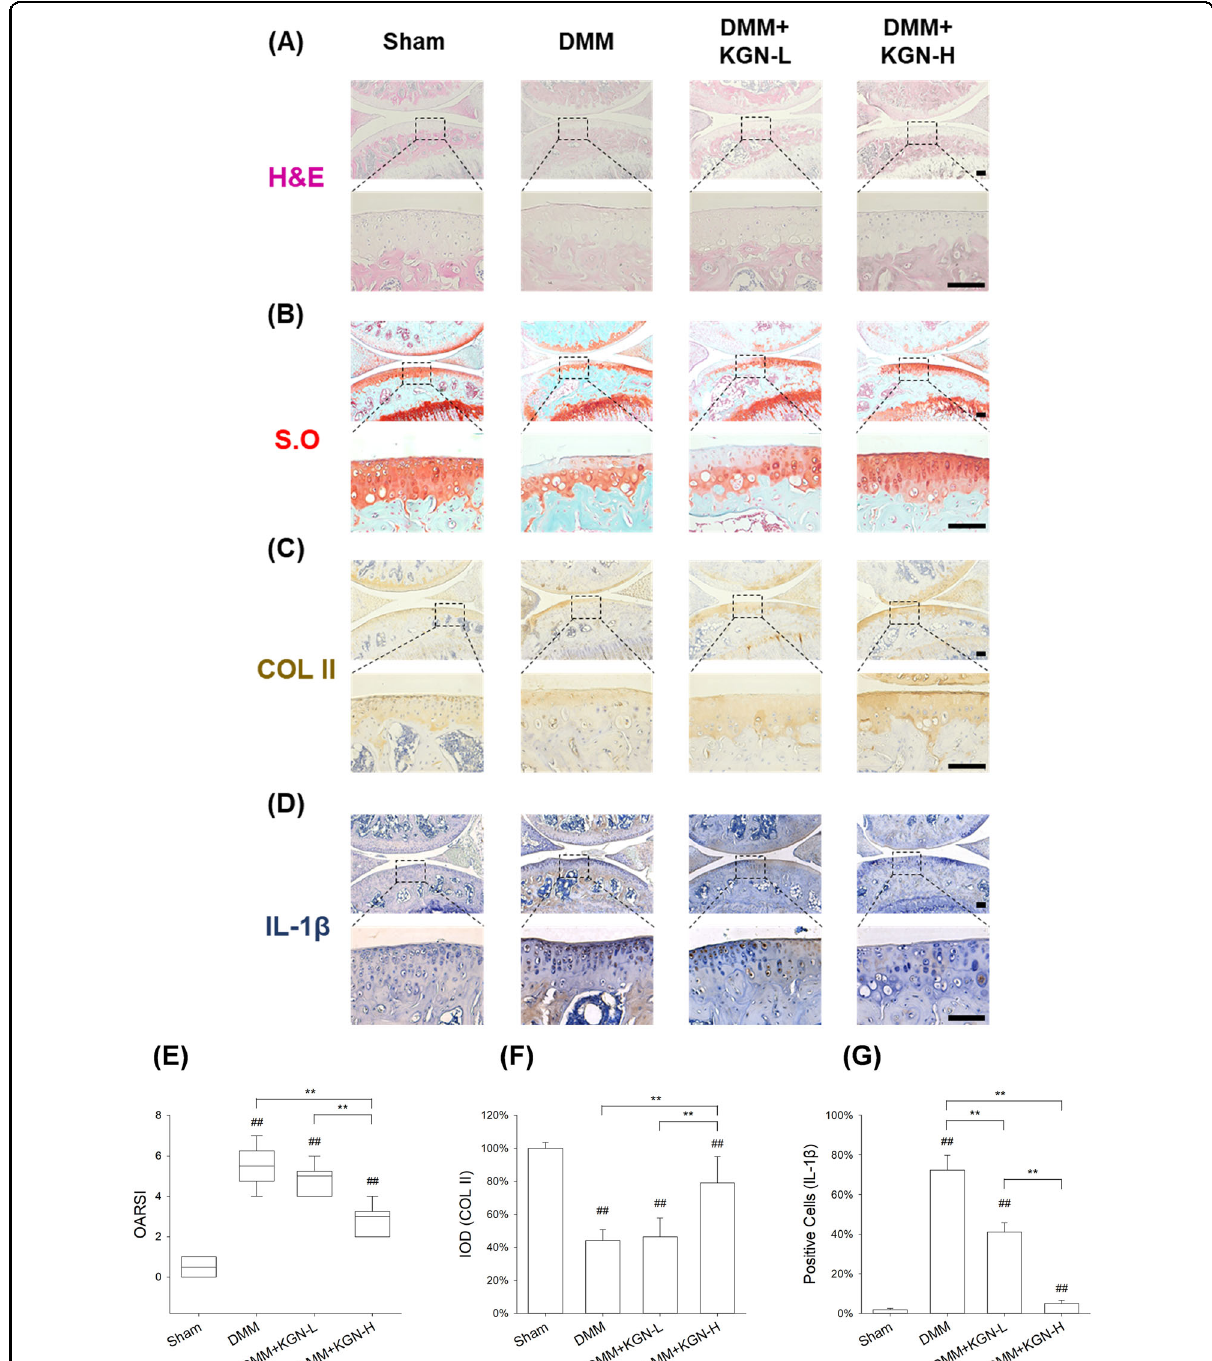
Fig. 3 Effect of intra-articular injection of KGN on the degeneration of cartilage in DMM-induced OA in mice. DMM-op mice were injected with 1 μ M or 100 μ M of KGN, twice a week for four weeks, whereas the controls were injected with 10 μ L of saline. A – D Representative histological images of medial femoral condyle and tibial plateau of OA mice following immunohistochemical staining. Sagittal sections of cartilage following A hematoxylin and eosin (H&E) staining, B Safranin O (S.O.)/Fast Green staining, C immunohistochemistry for COL II (IHC), and D immunohistochemistry for IL-1 β (IHC). (Scale bar = 100 μ m). E OARSI scores based on Safranin O/Fast Green staining. F Integrated optimal density (IOD) of COL II in articular cartilage. G Percentage of IL-1 β positive cells in articular cartilage. In each section, the quantitative analyses were performed at three random regions, with the average used as the fi nal value. Values represent mean ± S.E.M of six replicas. (* p < 0.05 and ** p < 0.01; between the indicated groups and # p < 0.05 or ## p < 0 . 01 versus the CTRL group).